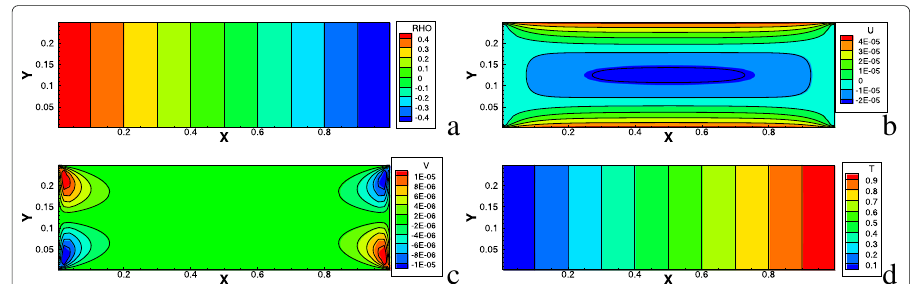
Fig. 14 The comparison of UGKS (contour) and NS (solid line) solution for the thermal creep flow. ( a ) density distribution; ( b ) x-directional velocity distribution; ( c ) y-directional velocity distribution; ( d ) temperature